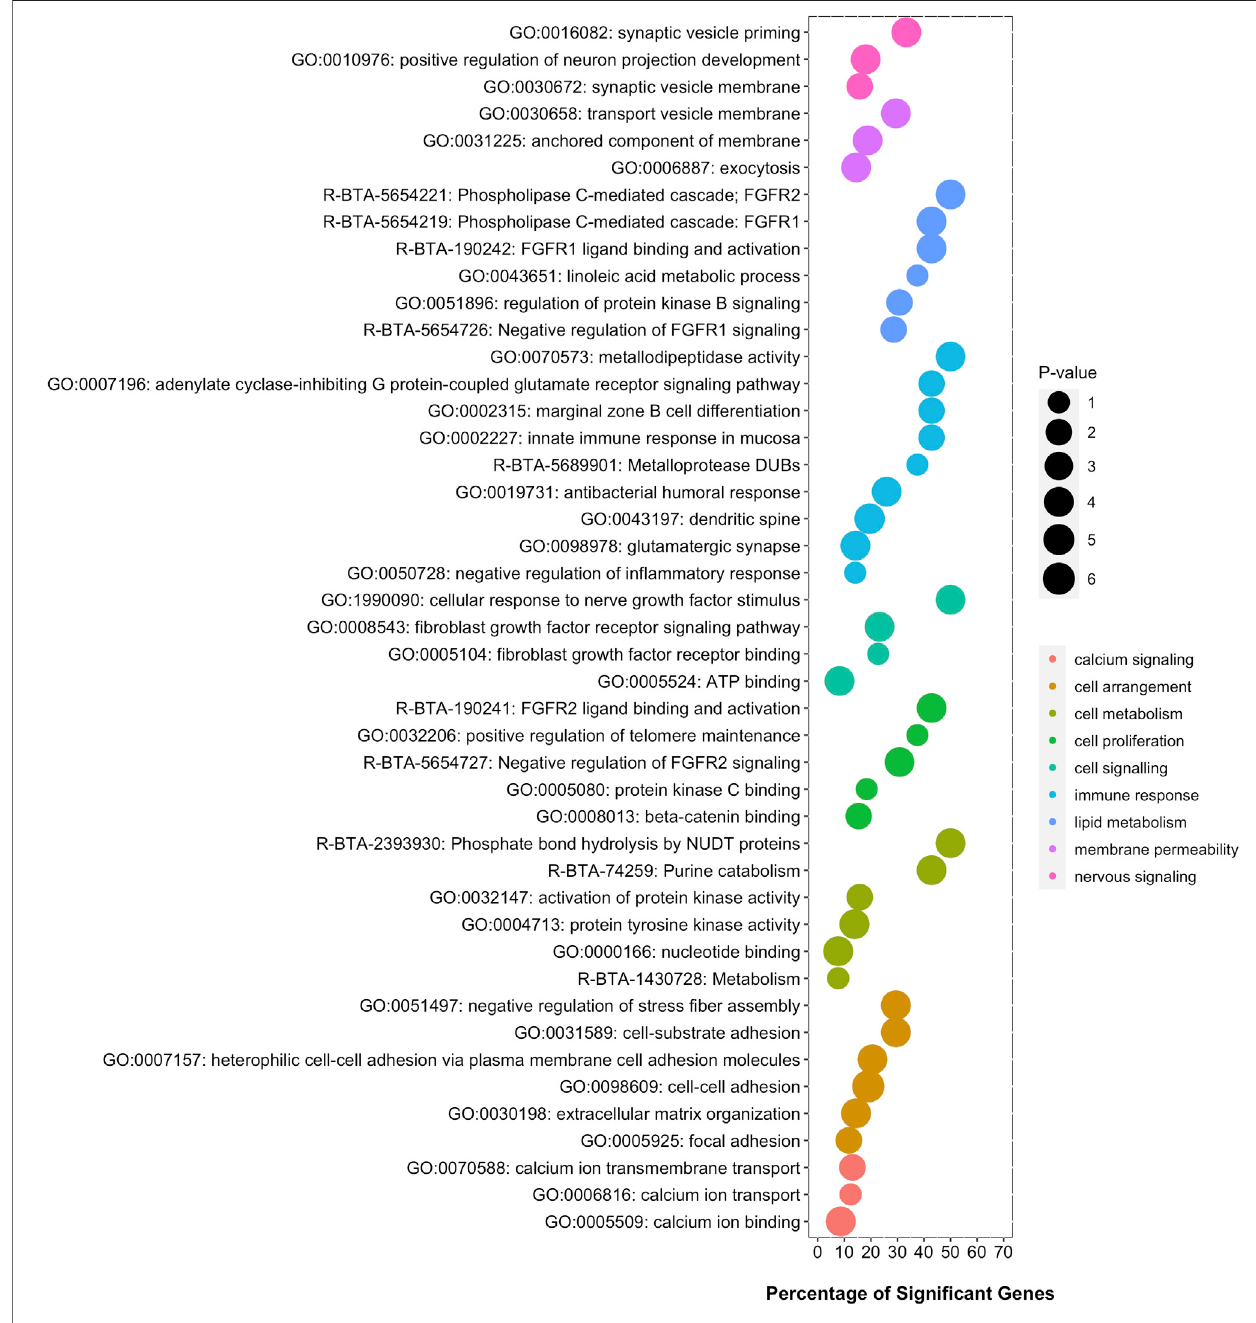
FIGURE 2 | Functional terms signi fi cantly enriched with genes associated with visceral fat accumulation. Six gene-set databases were analyzed: GO, KEGG, MeSH, InterPro, MSigDB, and Reactome. The y -axis displays the name while the x -axis displays the percentage of signi fi cant genes in each functional enriched term.